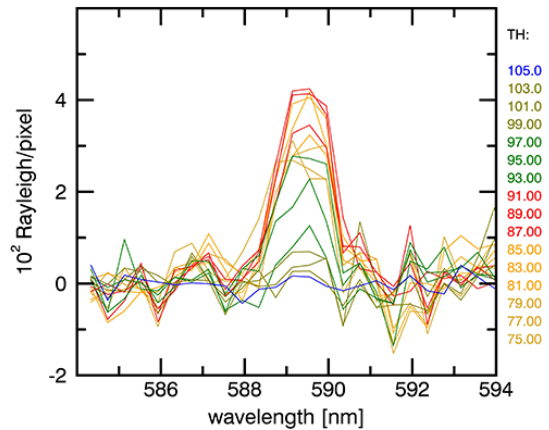
Figure 2. Monthly mean OSIRIS Na D-line nightglow spectra for April 2006 after offset and linear fit subtraction. Every colored spec- trum refers to one tangent height given on the right. Tangent heights are given in kilometers. For more details about the data preprocess- ing method we refer to Koch et al.